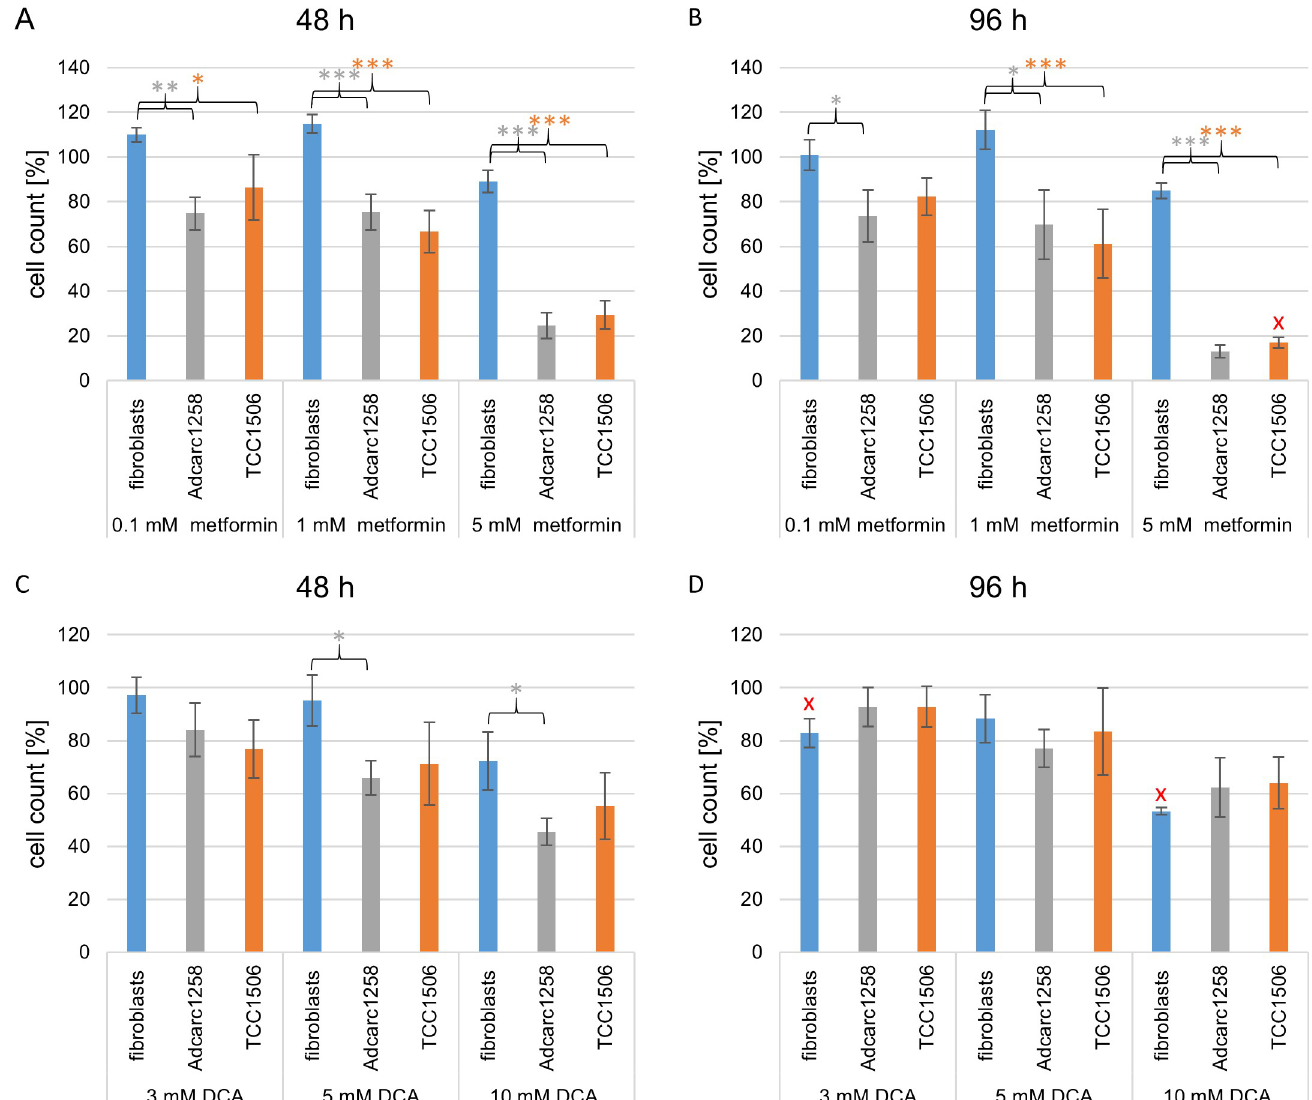
Fig 1. Cell count of fibroblasts, Adcarc1258 and TCC1506 after single metformin application (A and B) and single DCA application (C and D) over 48 h (A and C) and 96 h (B and D). An untreated control of the respective cell line served as a 100% reference. Means and standard deviation are displayed, n = 3. Gray asterisks: significance difference between fibroblasts and Adcarc1258. Orange asterisks: significant difference between fibroblasts and TCC1506. Red x: significant difference to the respective value at 48 h. significance is set at p � < 0.05, p �� < 0.01 and p ��� < 0.001, respectively.